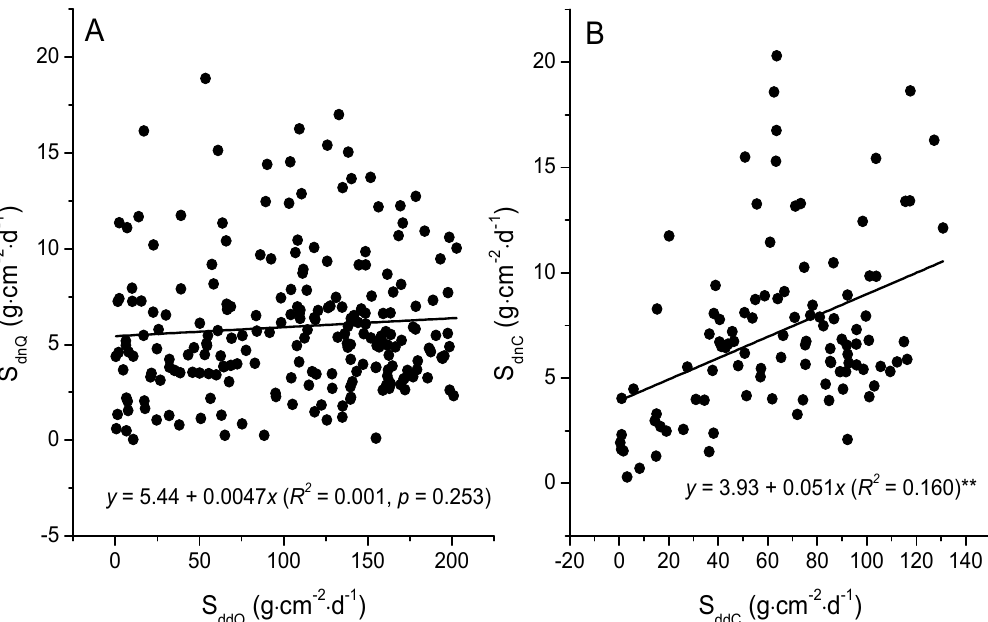
Figure 9. The relationships between daytime sap flow density (S dd ) and nocturnal sap flow density (S dn ). ( A ) Q. acutissima ; ( B ) C. lanceolata . ** Significant correlation at p < 0.01.